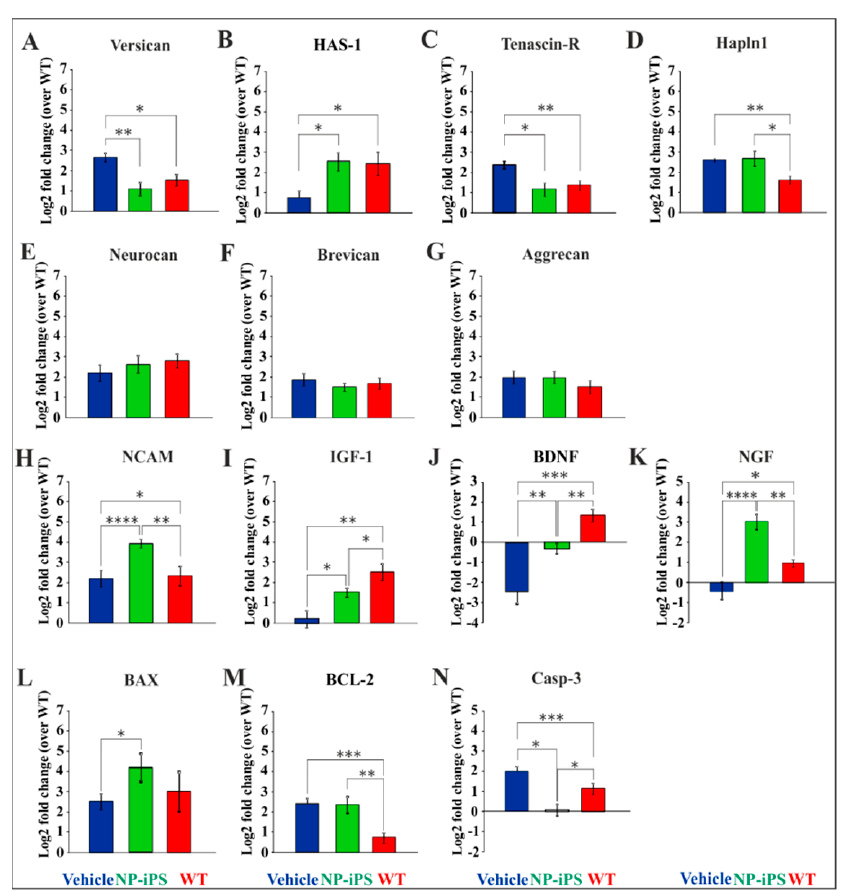
Figure 6. NP-iPS transplantation normalized the altered expression of spinal host genes. Seven PNN-related molecules of the ECM were tested. Vehicle-treated SOD1 rats had a significant dysregulation of versican ( A ), has-1 ( B ), tenascin-R ( C ), and hapln1 ( D ), which were recovered by NP-iPS transplantation. On the other hand, neurocan ( E ), brevican ( F ), and aggrecan ( G ) expression did not vary between the groups. Similarly, a significant dysregulation of genes encoding ncam ( H ) and growth factors igf-1 ( I ), bdnf ( J ), and ngf ( K ) was amended by NP-iPS. Cell-treated rats had significantly upregulated bax compared to vehicle-treated littermates ( L ). Both vehicle and cell-treated animals have upregulated apoptosis-related gene bcl-2 ( M ), while caspase-3 ( N ) was downregulated by the delivery of NP-iPS ( N ). Bars represent the means ± SEM of the signal values assessed by the 2 − ∆∆ Ct method normalized to two endogenous reference genes, which were recalculated to relative quantities and transformed to a log2 scale. Differences in the groups were analyzed by one-way ANOVA: statistical significance at p values under 0.05 (*), p < 0.01 (**), p < 0.001 (***) and p < 0.0001 (****).